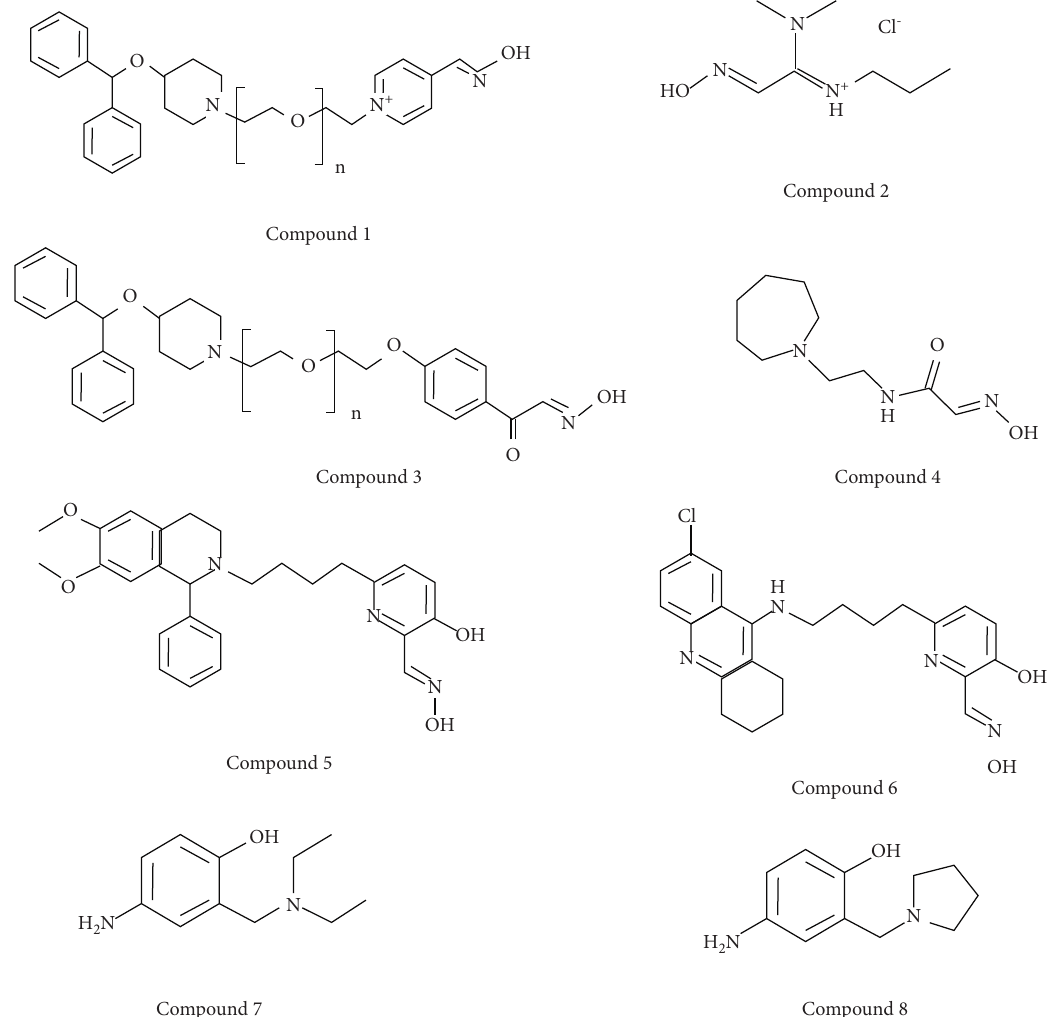
Figure 11: Example of uncharged oxime and nonoxime reactivators. Compounds 1–6 show primarily oximes, while 7-8 show nonoxime reactivators. Pictures were adapted from